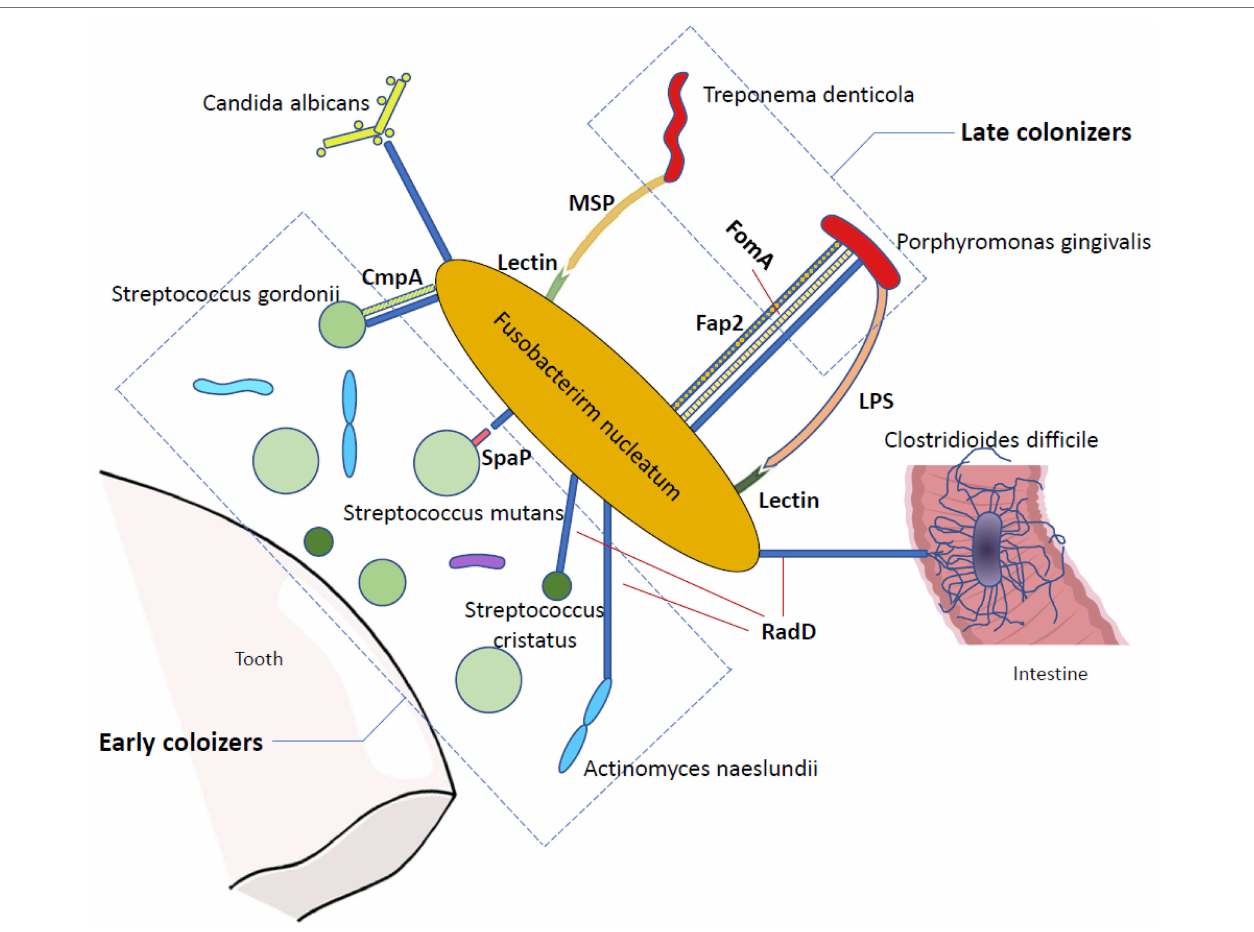
FIGURE 1 | The bridging function of Fusobacterium nucleatum in biofilm formation. Fusobacterium nucleatum is a bridging organism that has a great ability to bind to many other microorganisms. In the oral cavity, Fusobacterium nucleatum adheres to both early and late colonizers, promoting the coaggregation of periodontal disease-related pathogens. In addition, it can bind to Candida albicans and Clostridioides difficile . RadD is one of the most profoundly studied adhesions of Fusobacterium nucleatum and contributes to the binding between Fusobacterium nucleatum and Candida albicans , Streptococcus cristatus ,